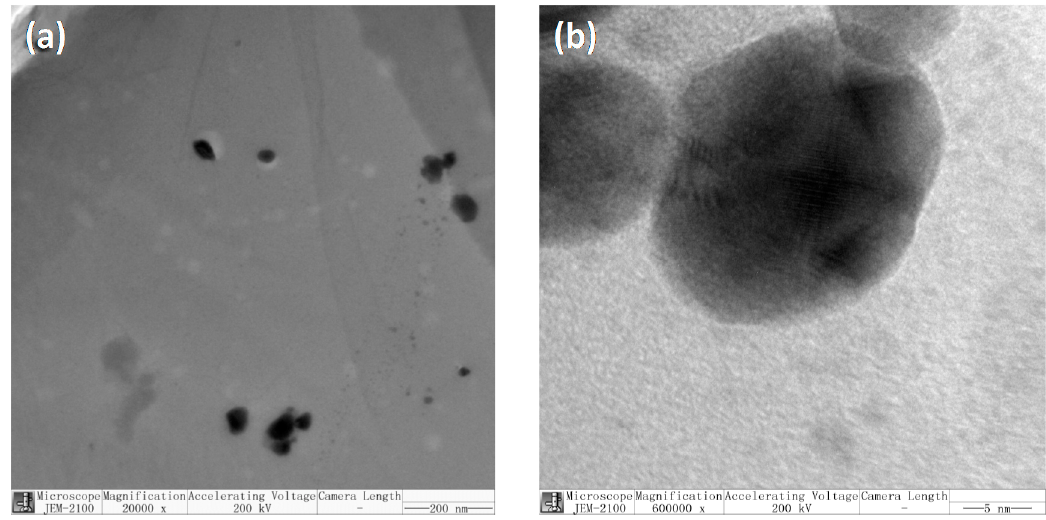
Figure 4. TEM micrographs of Z3, ( a ) 20,000× and ( b ) 600,000×.